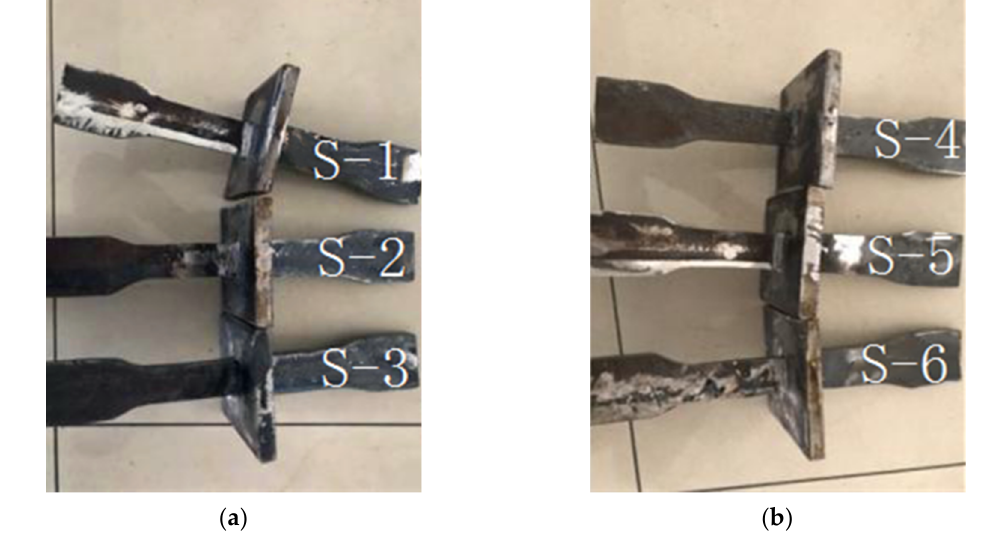
Figure 1. Welded plate joint specimens: ( a ) monotonic loading test set; ( b ) cyclic loading test set.